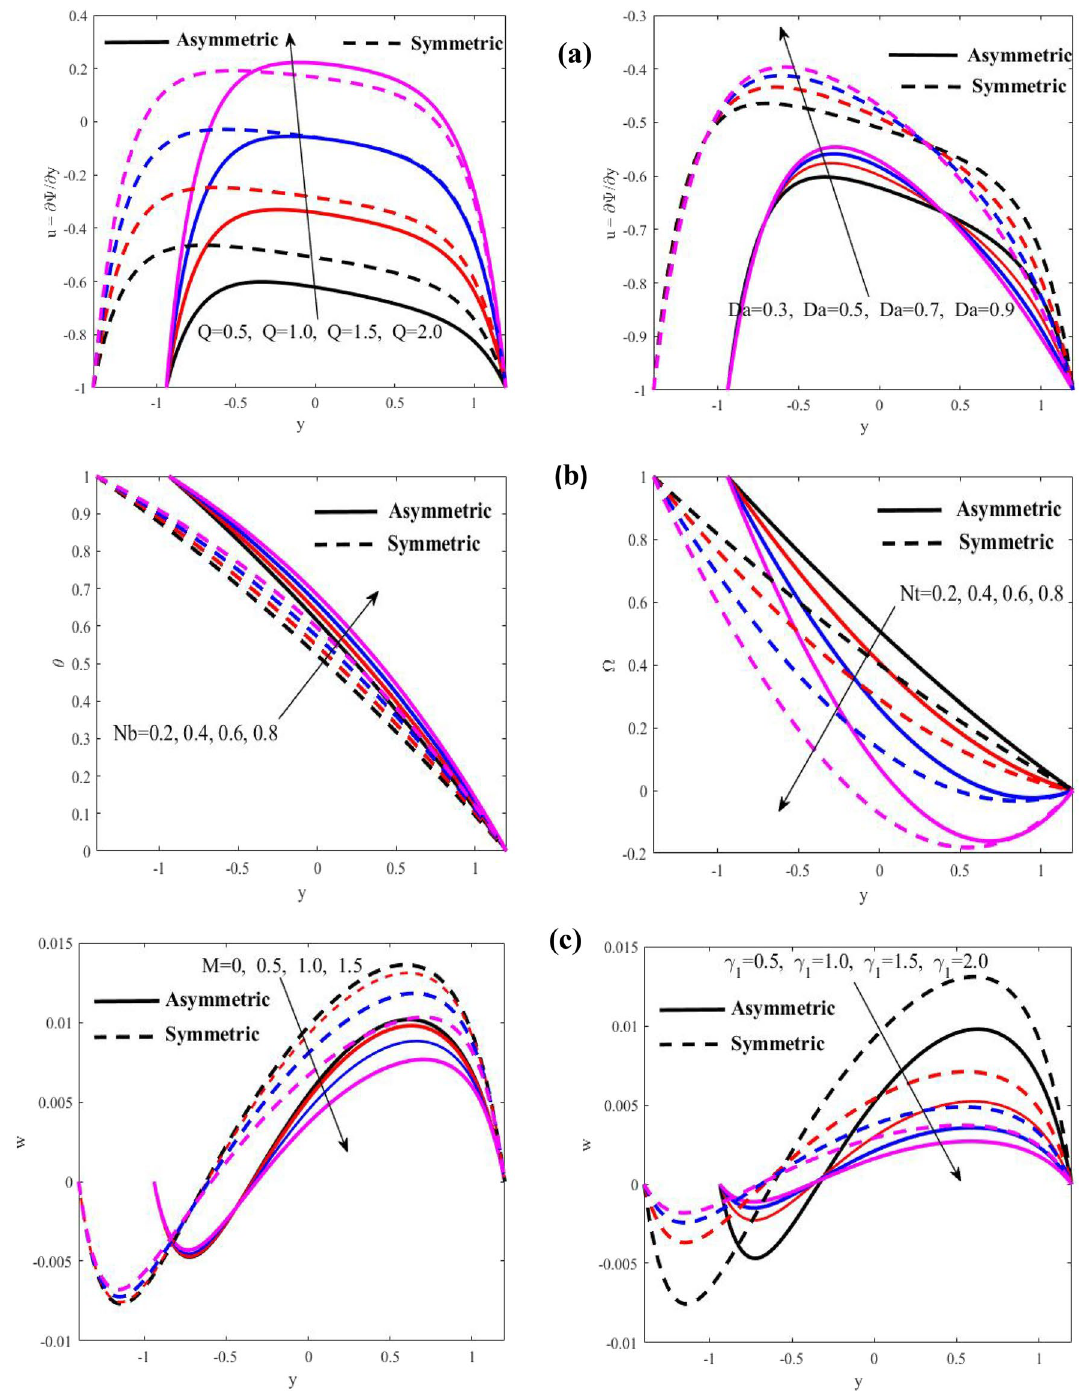
Figure 8. Discrepancies of the velocity u , the temperature θ , and the microrotation velocity w in two different cases. ( a ) Discrepancies of u against Q and Da . ( b ) Discrepancies of θ and (cid:31) against Nb and Nt , respectively. ( c ) Discrepancies of w against M and γ 1